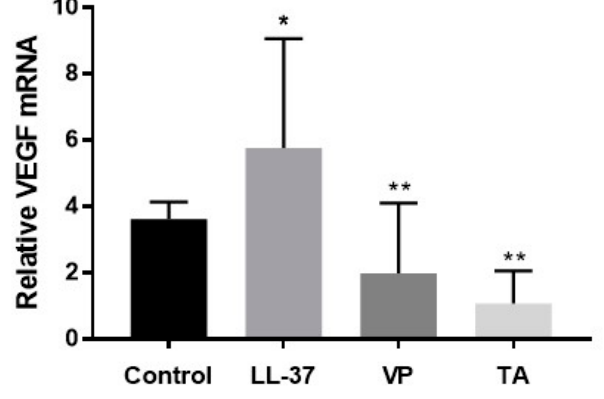
Figure 3. Quantitative polymerase chain reaction (qPCR) analyses of VEGF mRNA expression. Data represent the means and SEMs of three independent experiments ( n = 3 for the control group and n = 5–6 for the other groups). * p < 0.05 (control group vs. LL-37 group), ** p < 0.01 (LL-37 group vs. verteporfin (VP) and triamcinolone (TA) groups) (Mann–Whitney U test).